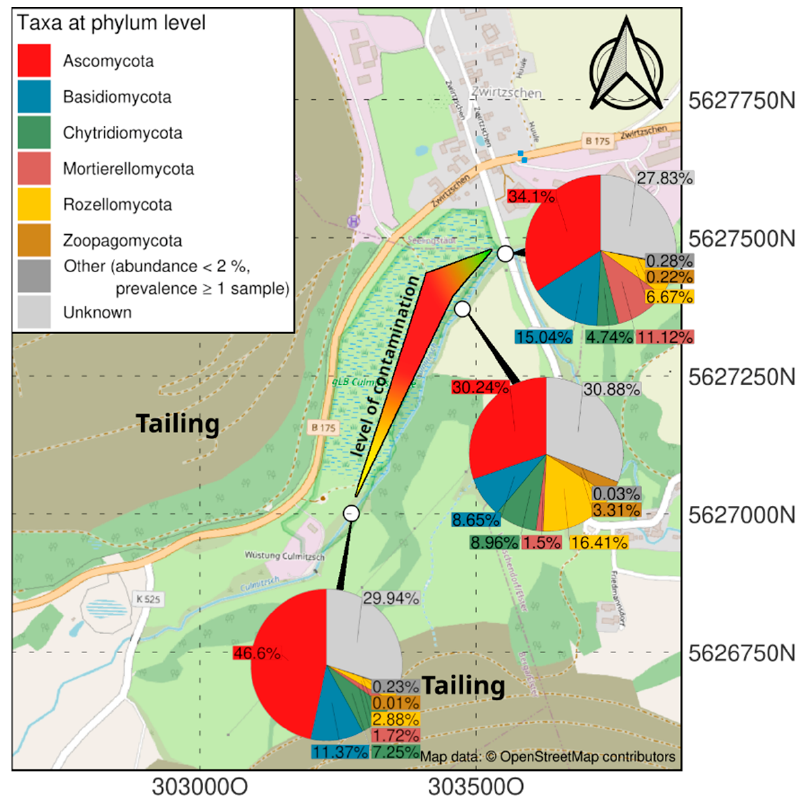
Figure 1. Map showing the contamination gradient (compare suppl. Table S1) and the respective mycobiomes at three sampling sites.